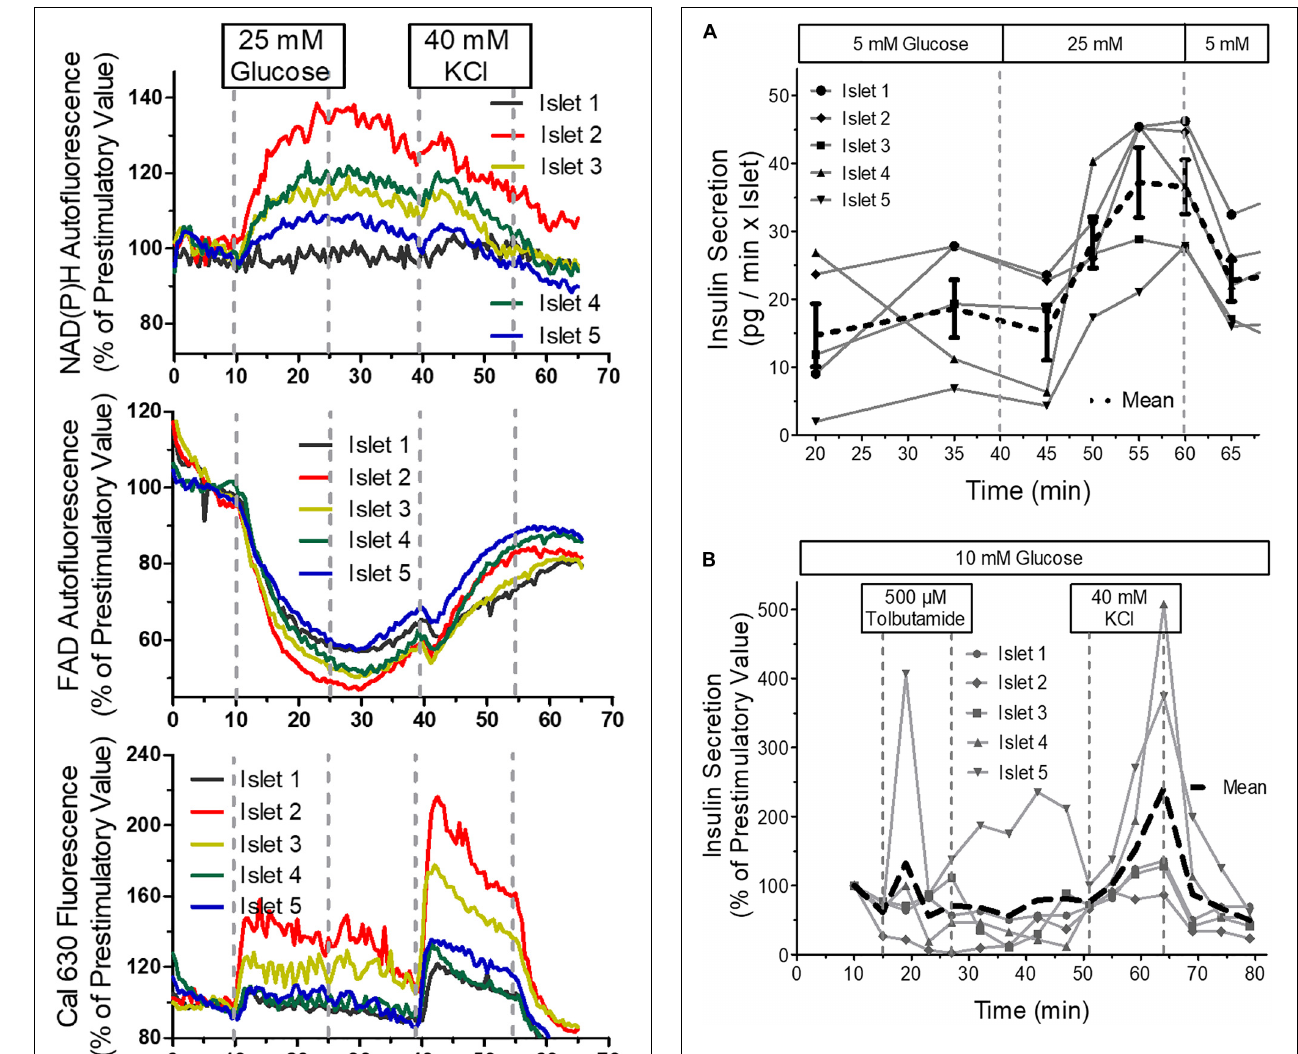
FIGURE 10 | Insulin secretion of parallel perifused islets in the microfluidic system. Five islets of similar size were placed in the wells, one each per well, and perifused with KR medium. The efflux of the medium was collected by a 96 well plate and the insulin content of the fractions was determined by ultrasensitive ELISA. (A) From 40 to 60 min the glucose concentration of the perifusion medium was increased from 5 to 25mM glucose. Shown are the single values and the means of five independently perifused islets. Note the incomplete return to prestimulatory values during the wash-out of the glucose stimulus. (B) From 15 to 27 min the islets were stimulated with 500 µ M tolbutamide and from 51 to 64 min with 40 mM KCl. Shown are the single values and the means of five independently perifused islets. This experiment was conducted at 22 ◦ C. Still, there is a substantial increase of secretion in response to 40 mM